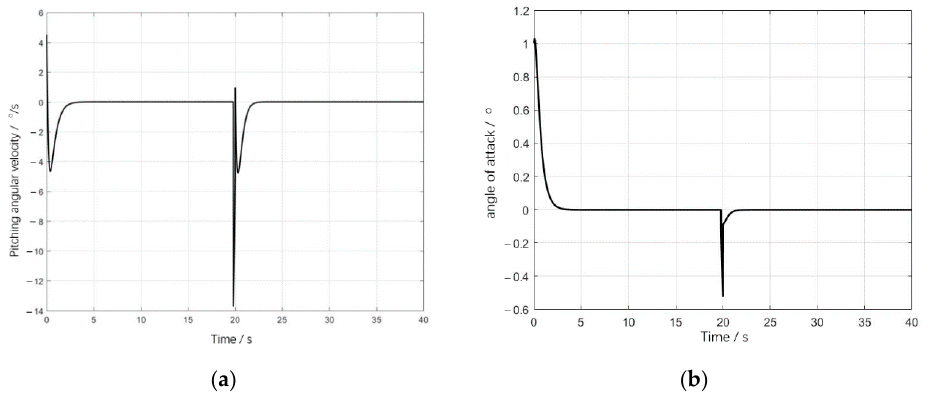
Figure 10. ( a ) State-response graph of the pitching angular velocity; ( b ) state-response graph of the power angle.